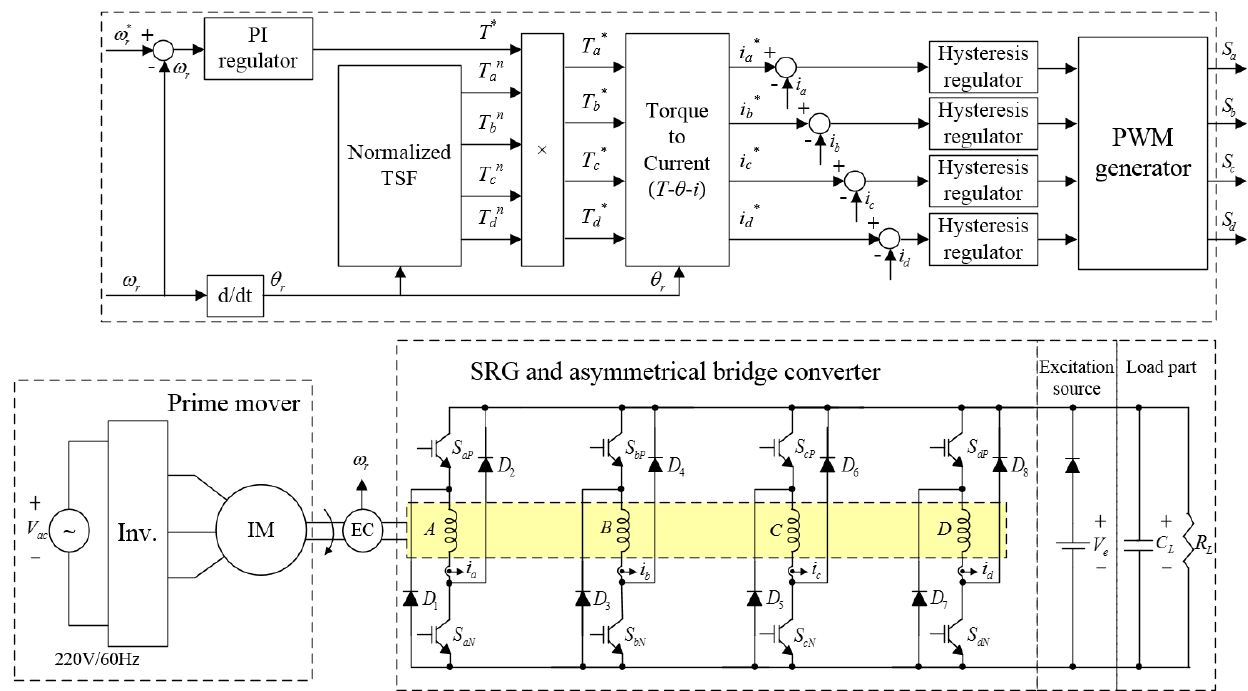
Figure 4. Overall torque control scheme of the Torque Sharing Function (TSF)